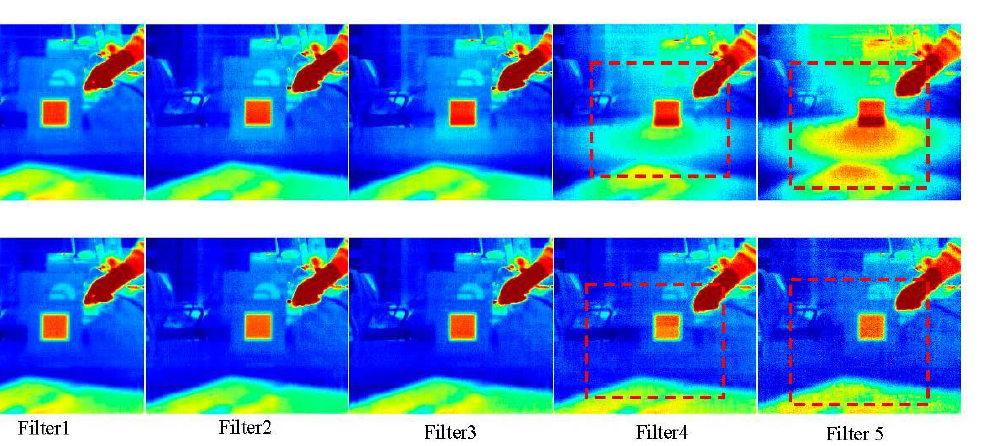
Figure 3. Spectral transmittance curve of wideband filters, camera responding curve, and absorp- tion coefficient of SF6. All transmittance curves are shifted to be easily distinguished. SF6 absorption coefficient is normalized for clear presentation.